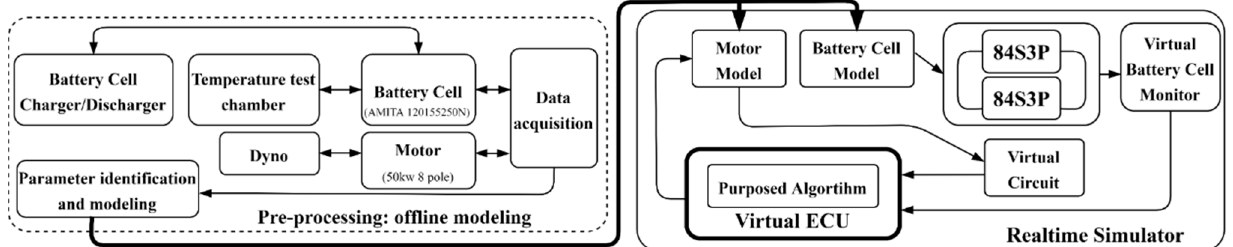
Figure 9. MIL evaluation environment architecture.